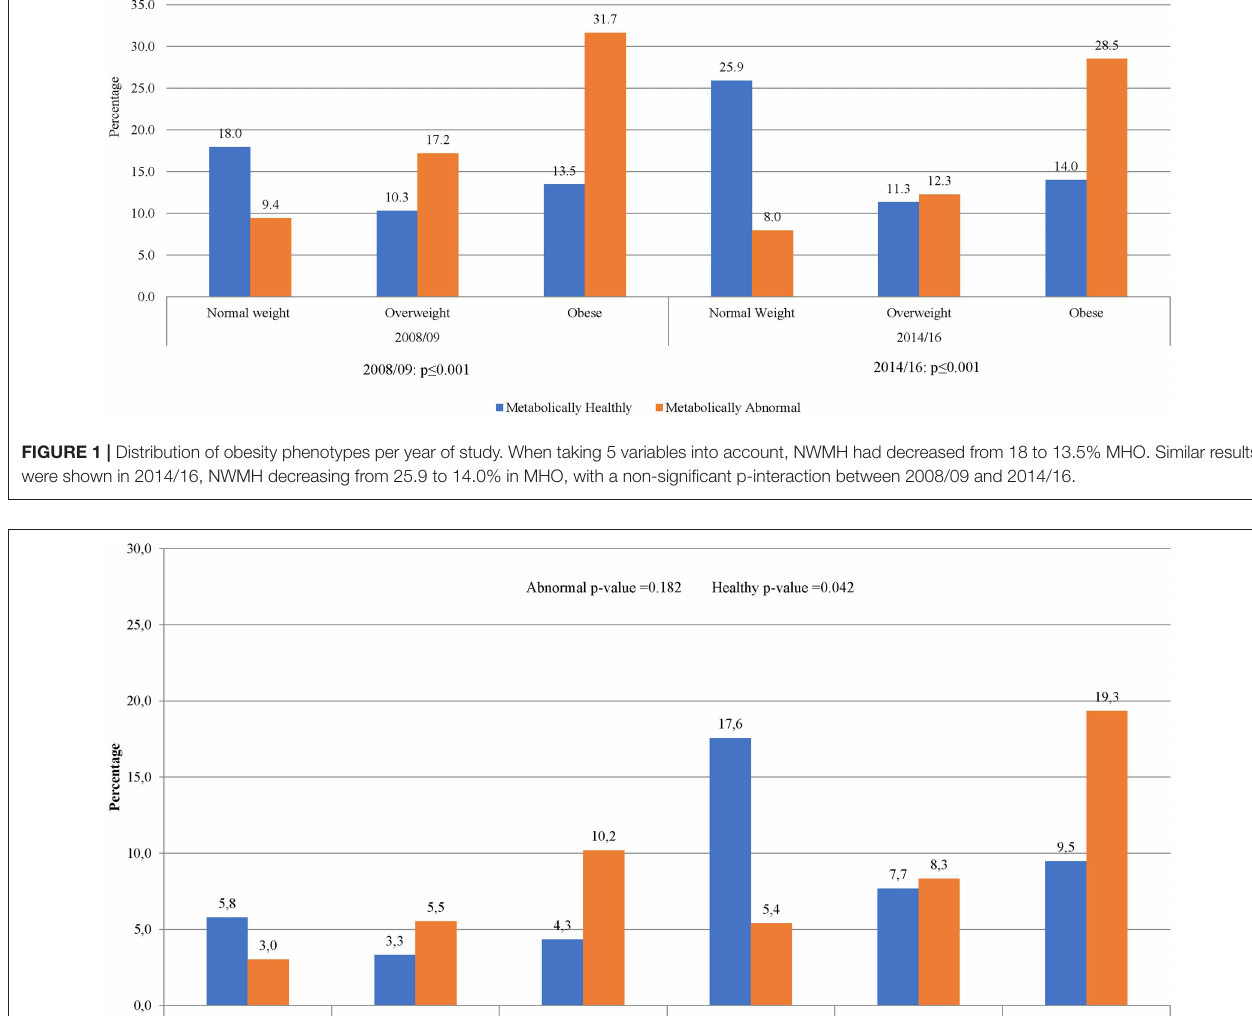
0.001 for linear trend), with no evidence of interaction by year (interaction p = 0.225) ( Supplementary Figure 1 ). As expected, the proportion of metabolically healthy participants decreased overall and across all BMI categories and years of survey. The above patterns were mostly similar in women, but